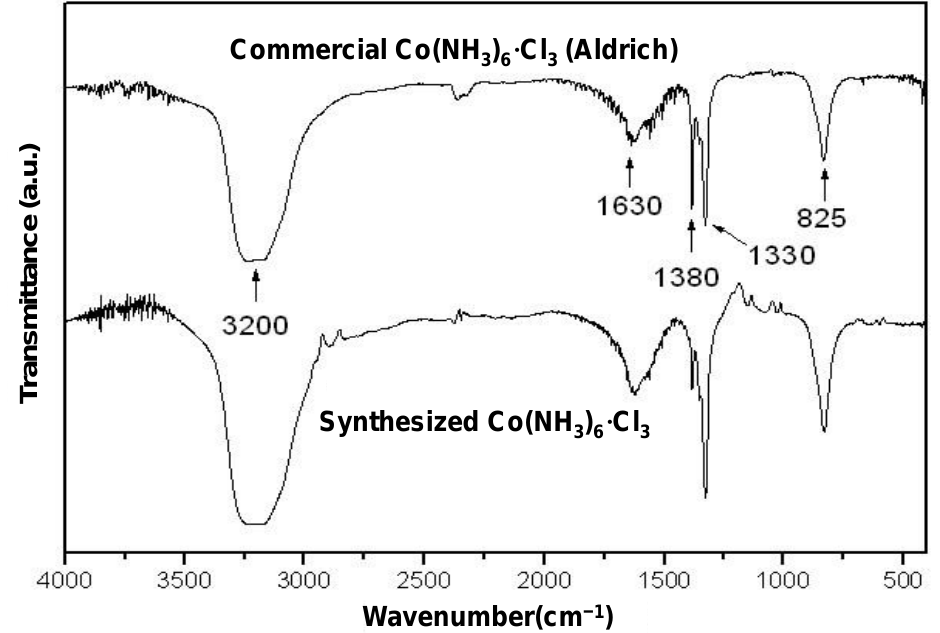
Figure 3. FTIR spectra comparison between the commercially available hexaamminecobalt(III) chloride (top) and synthesized hexaamminecobalt(III) chloride (bottom).